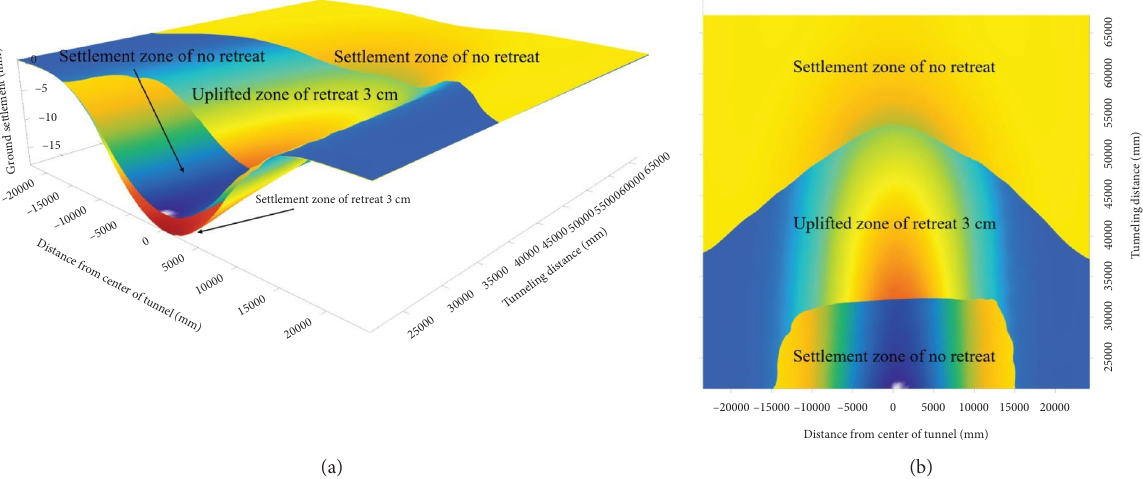
Figure 20: 3D map and plane map of settlement superposition when no retreat and 3 cm retreat of pipe section: (a) No retreat and retreat 3cm settlement superimposed 3D map. (b) No retreat and retreat 3cm settlement superposition plane